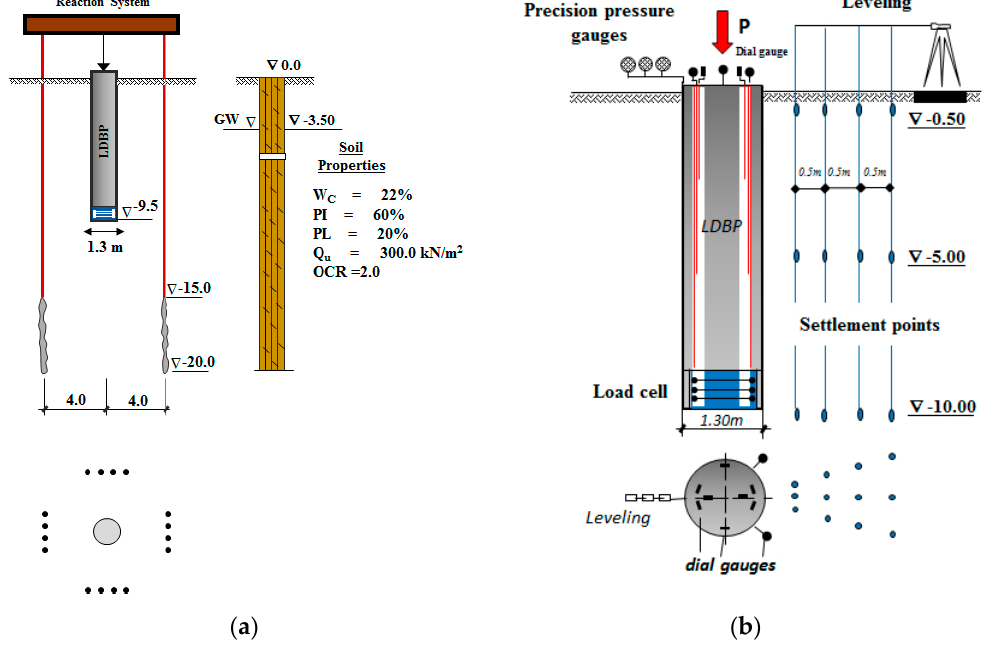
Figure 1. Large diameter bored pile load test [12]. ( a ) Test arrangement and typical soil profile with mechanical properties (Modified from [12]). ( b ) Measuring devices and instrumentations (Modified from [12]).